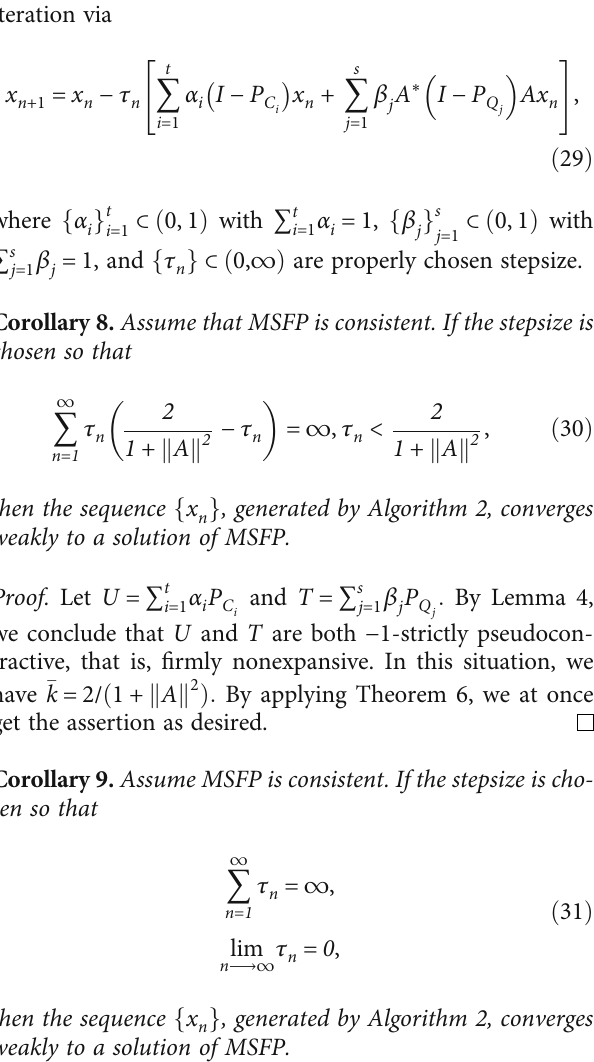
Algorithm 2. Let x 0 be arbitrary. Given x n , update the next